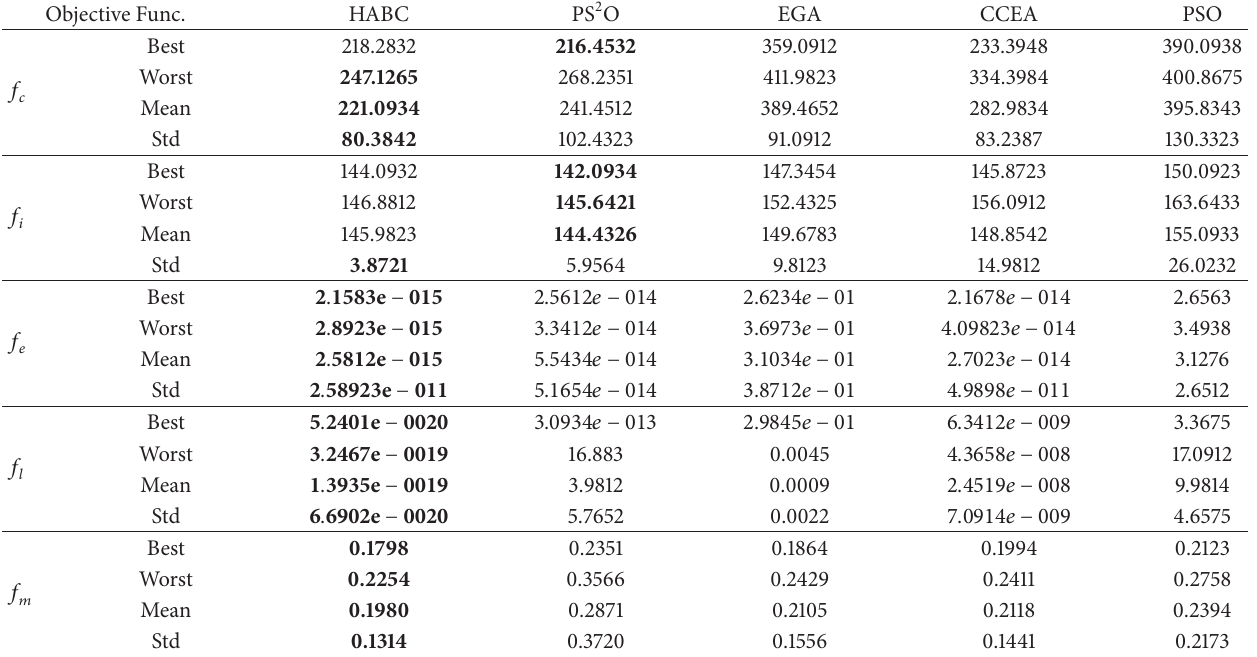
Table 7: Performance of all algorithms on RNP with